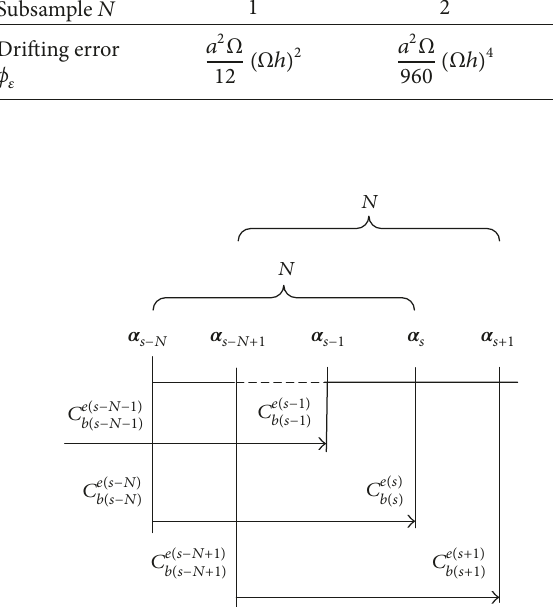
Figure 3: Frame of real-time attitude